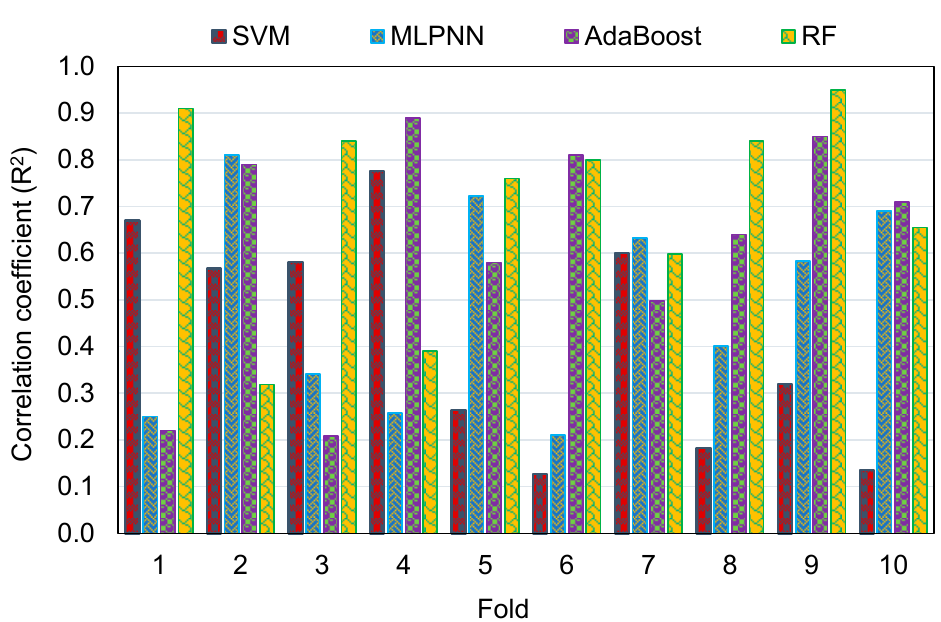
Figure 18. Comparison of the correlation coefficient for all models from the k-fold analysis.